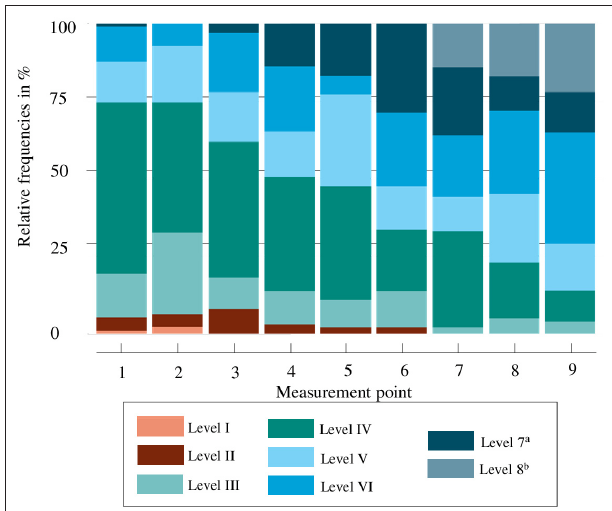
FIGURE 1 | Level-based analysis of the LPA ( N = 101). a Level 7 is not a level of the developmental model. In this figure, Level 7 includes students who mastered at least 75% of the items at Level VI. b Level 8 is not a level of the developmental model. In this figure, Level 8 includes students who mastered at least 75% of the items at Levels V and VI in a higher number